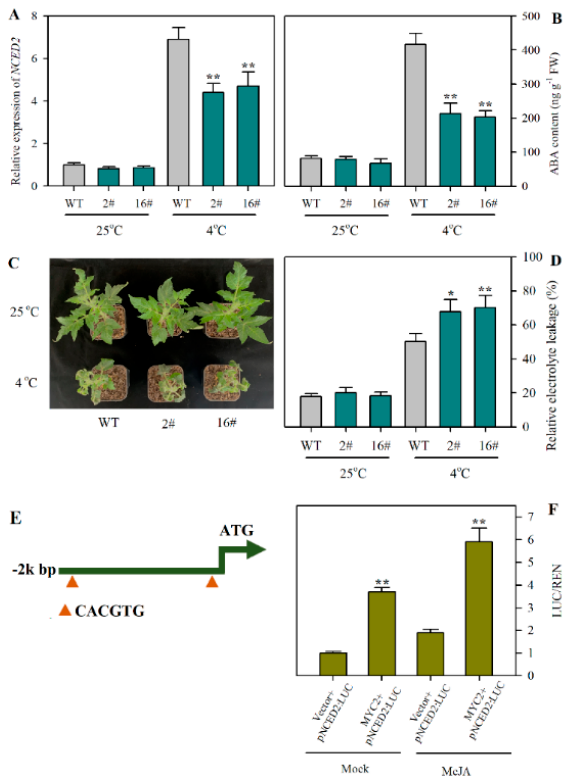
Figure 5. MYC2 regulates the transcription of NCED2 and cold tolerance in tomato. ( A ) Alterations in the relative expression of NCED2 as affected by the suppression of MYC2 in tomato under cold stress. ( B ) Alterations in ABA content as affected by the suppression of MYC2 in tomato under cold stress. ( C ) Phenotypes of MYC2 -RNAi plants under cold stress. ( D ) Relative electrolyte leakage in MYC2 -RNAi plants under cold stress. ( E ) Predicted binding sites of MYC2 in the promoter region of NCED2 . ( F ) Dual-luciferase analysis of MYC2 binding to NCED2 promoter. Relative activity is shown by LUC/REN. Data presented are means of three biological replicates ( ± SD). Asterisks indicate significant differences (** p < 0.01, * p < 0.05) according to Student’s t -test.